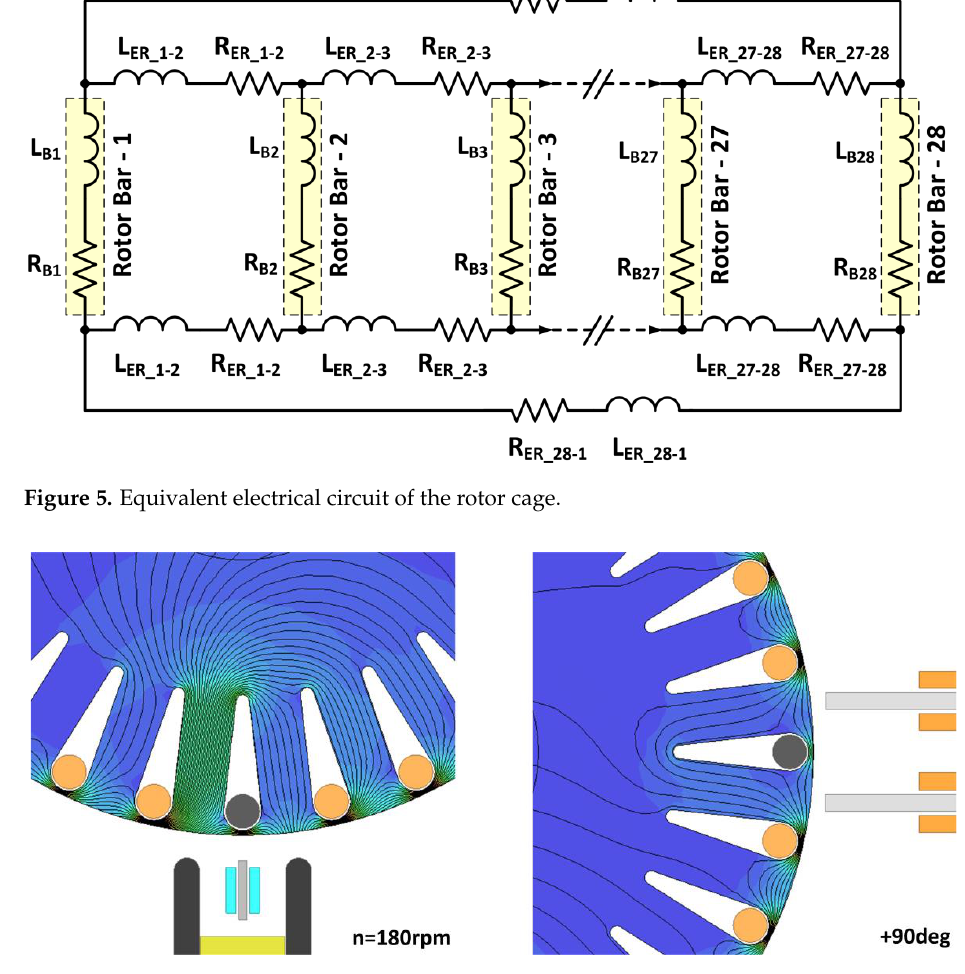
Figure 5. Equivalent electrical circuit of the rotor cage.